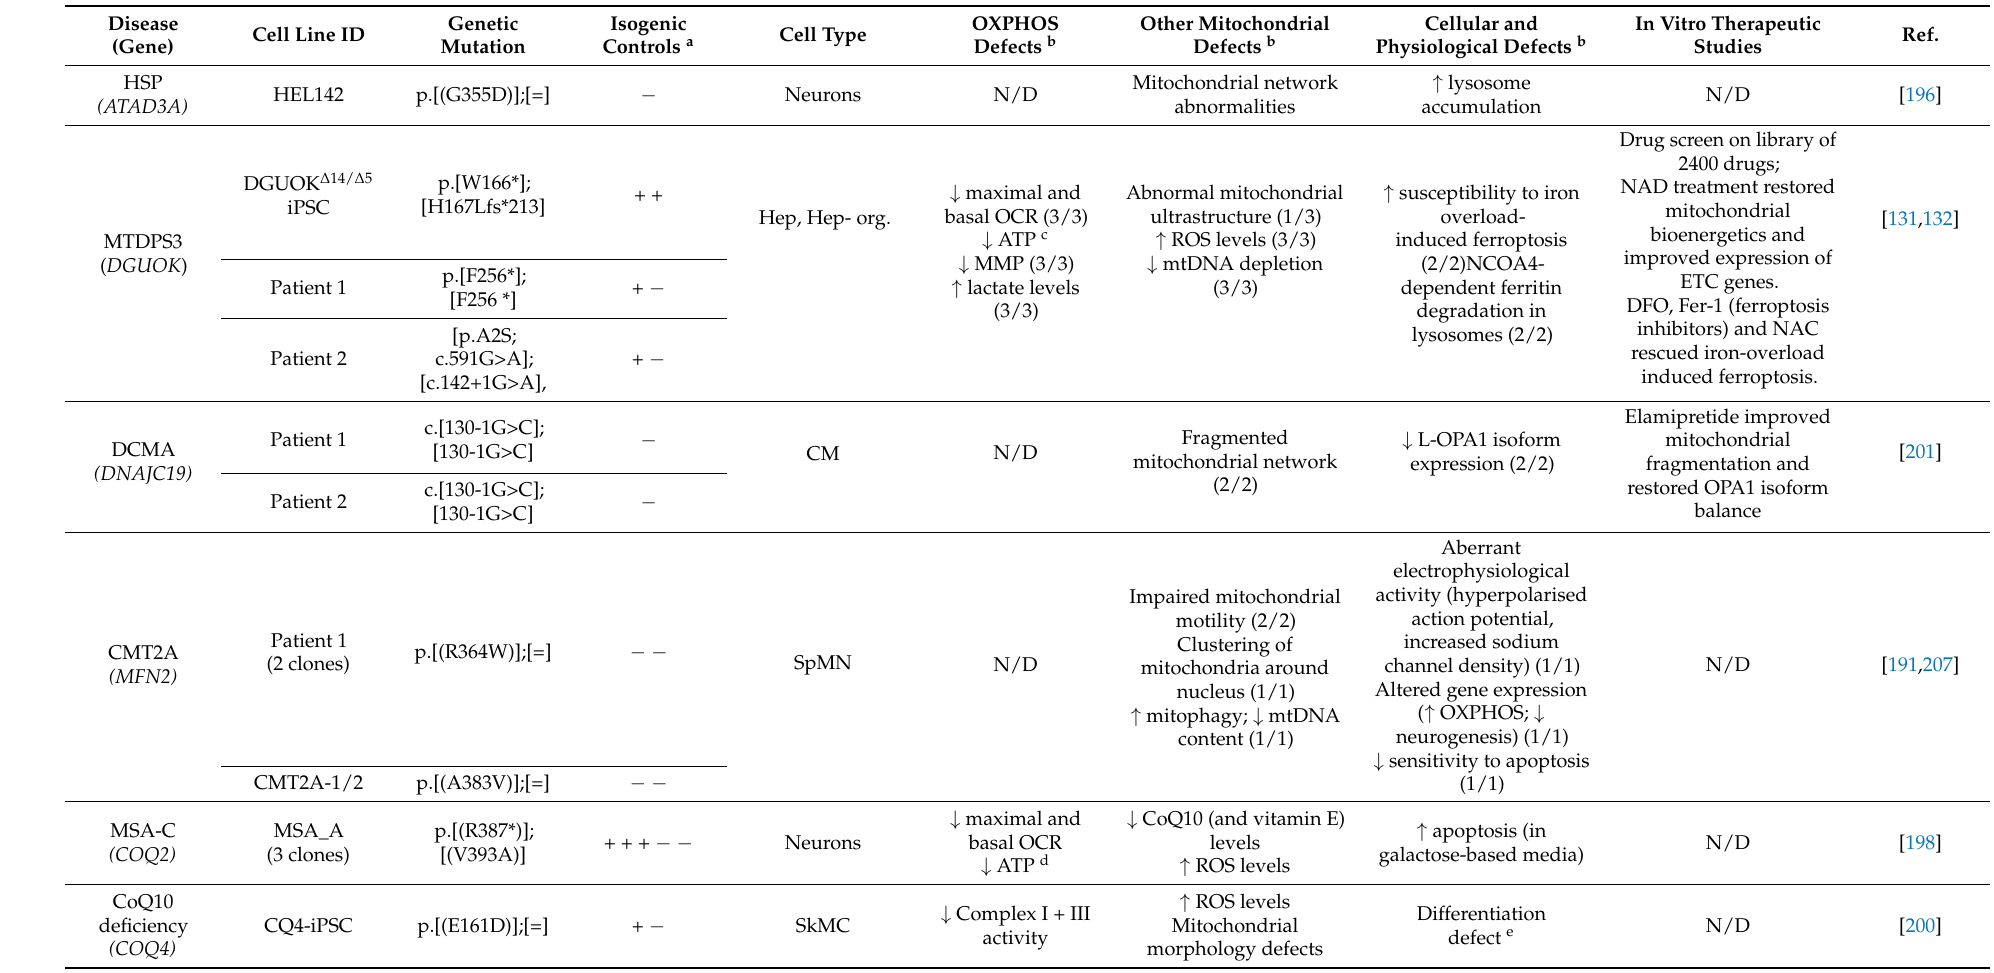
Table A3. Summary of functional defects of hPSC-derived clinically relevant cell types of nDNA associated mitochondrial diseases. Disease